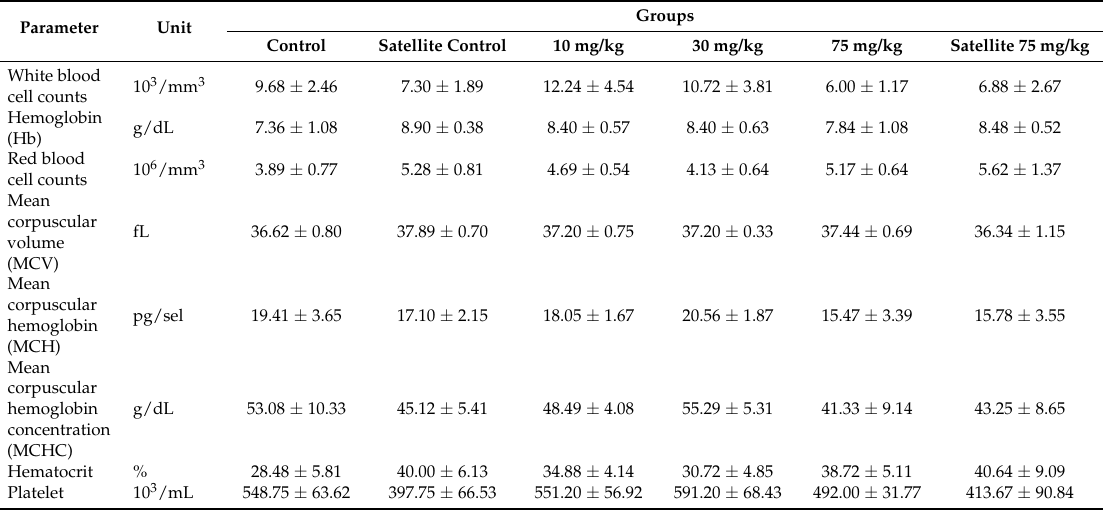
Table 4. Hematological profile of female rats treated with different doses of the film formulation for 28 days.